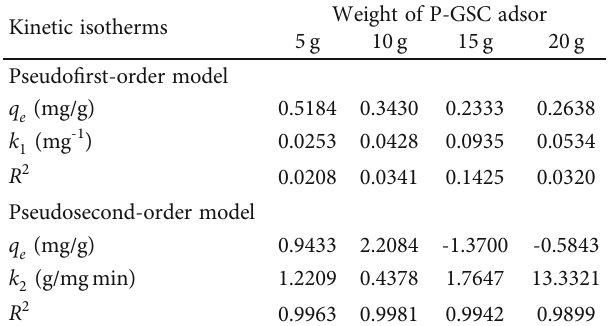
Table 2: Kinetic isotherms for di ff erent weights of small-sized P- GSC.